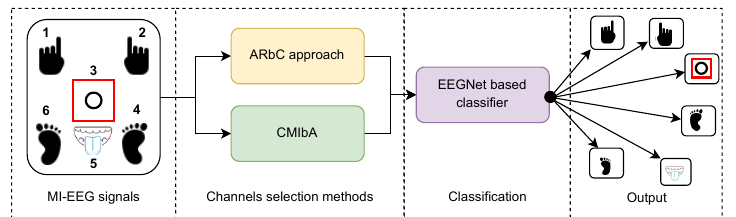
Figure 1. The proposed method overall flowchart. EEG signals of six MI tasks are provided by [40]. The red rectangle centered on the circle refers to “Passive” and moves according to the subject’s MI task. The first step consists of selecting discriminant channels from the 19 provided. Next, two comparative methods are used: the ARbC method and the CMIbA. Therefore, the EEGNet network classifies the feature signals into six classes to give the output.